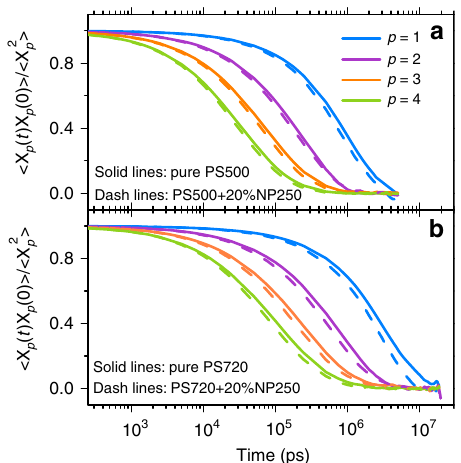
Fig. 3 The time autocorrelation function for four lowest Rouse modes of linear PS chains in a PS500 and b PS720 systems. Solid lines are for pure PS melts and dash lines are for PNCs with a 20% loading of NP250,